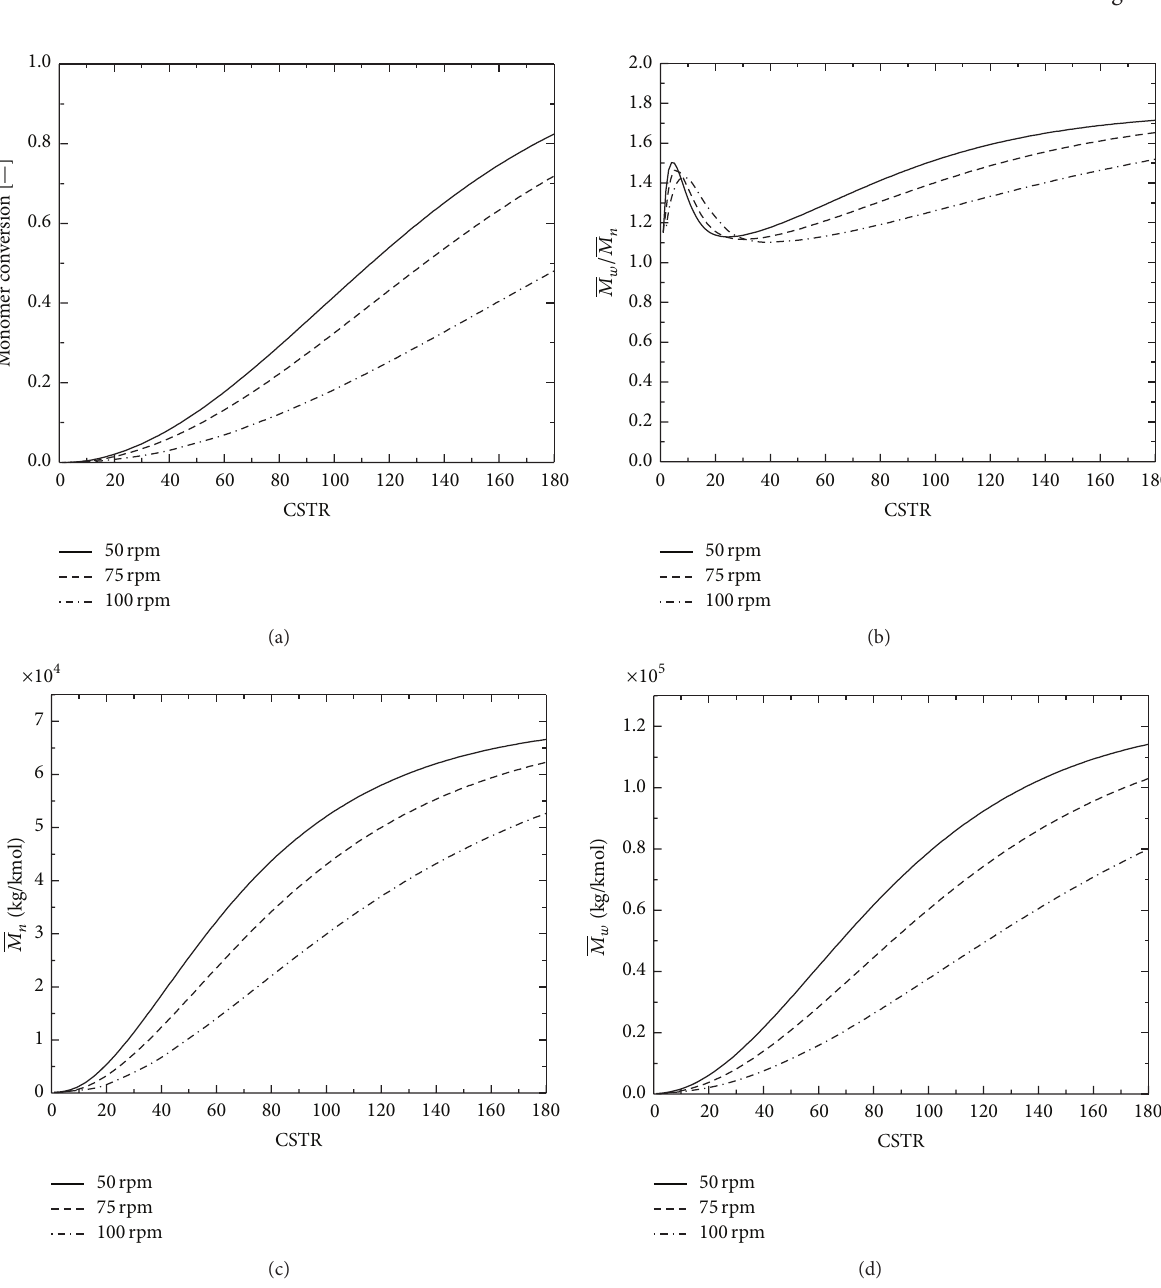
Figure 7: Effect of the screw speed on (a) the monomer conversion, (b) polydispersity index, (c) the weight average molecular number 𝑀 𝑛 , and (d) the weight average molecular weight 𝑀 𝑤 , at 𝑇 = 190 ∘ C, 𝑀 0 /𝐼 0 = 2250 , and rpm =